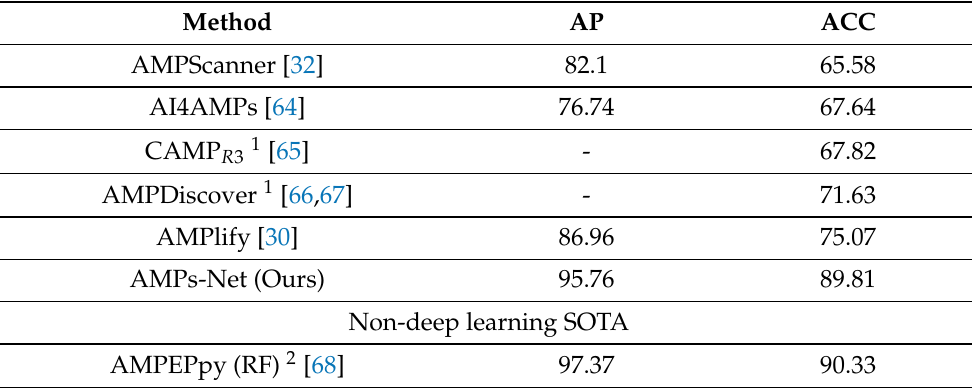
Table 4. Comparison with SOTA. We compare AMPs-Net with multiple state-of-the-art deep learning methods and the best Random Forest algorithm. For comparison with DL methods, pre-trained models or prediction servers were used; no retraining was possible due to a lack of public or non- working codes. 1 Prediction servers failed to return the probability scores; therefore, we failed to calculate AP. 2 Best Random Forest algorithm to date as it was retrained with our